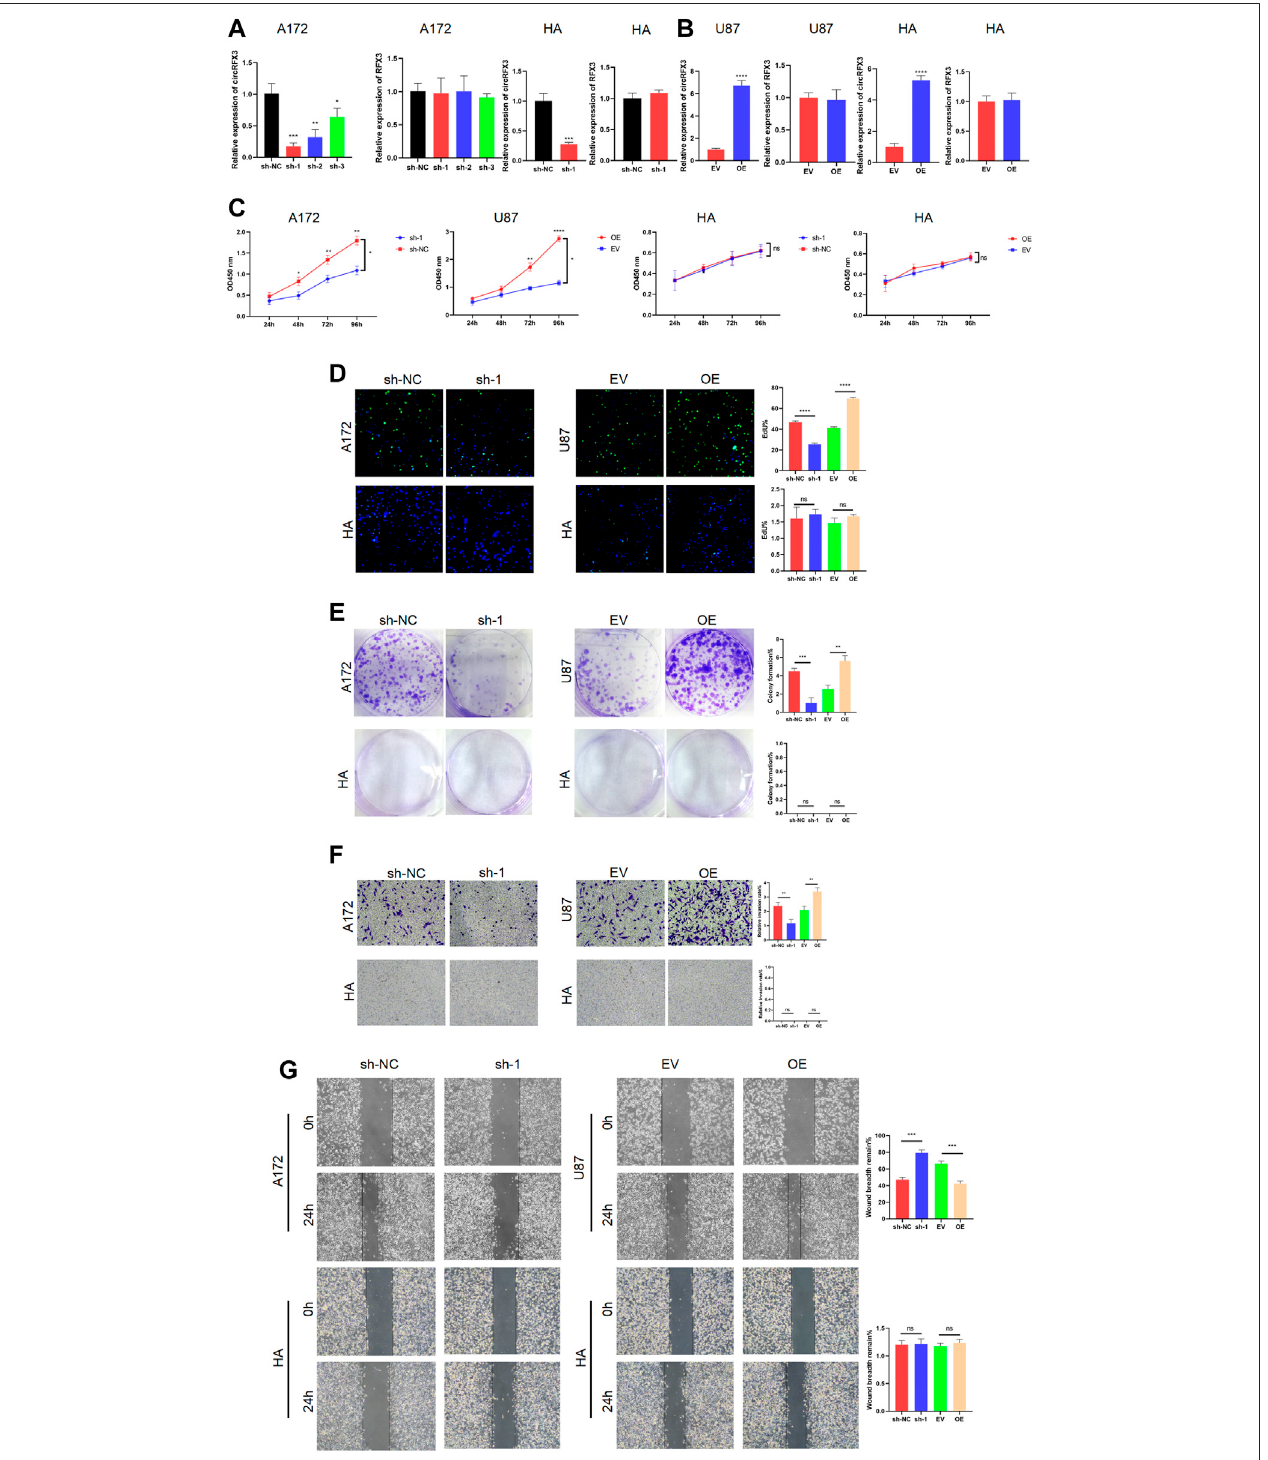
FIGURE2| circRFX3promotedtheproliferation,invasion,andmigrationofglioblastoma invitro . (A) circRFX3expressionwasobviouslyinhibitedbyshRNAs,while RFX3mRNAdid notchange. (B) circRFX3expression wasobviouslypromoted, whereasnoapparent changeinRFX3 mRNAwasdetected. (C,D) TheCCK-8 andEdU assaysshowed that A172cellproliferationcouldbe suppressed bytheinhibition ofcircRFX3 expression, whereas U87proliferationcould be obviously promoted bythe overexpressionofcircRFX3.Humanastrocyte(HA)proliferationcouldnotbein fl uencedbytheknockdownoroverexpressionofcircRFX3. (E) Thecolonyformation assays showed that the A172 cell colonies were signi fi cantly decreased after circRFX3 knockdown, while more U87 cell colonies were formed after circRFX3